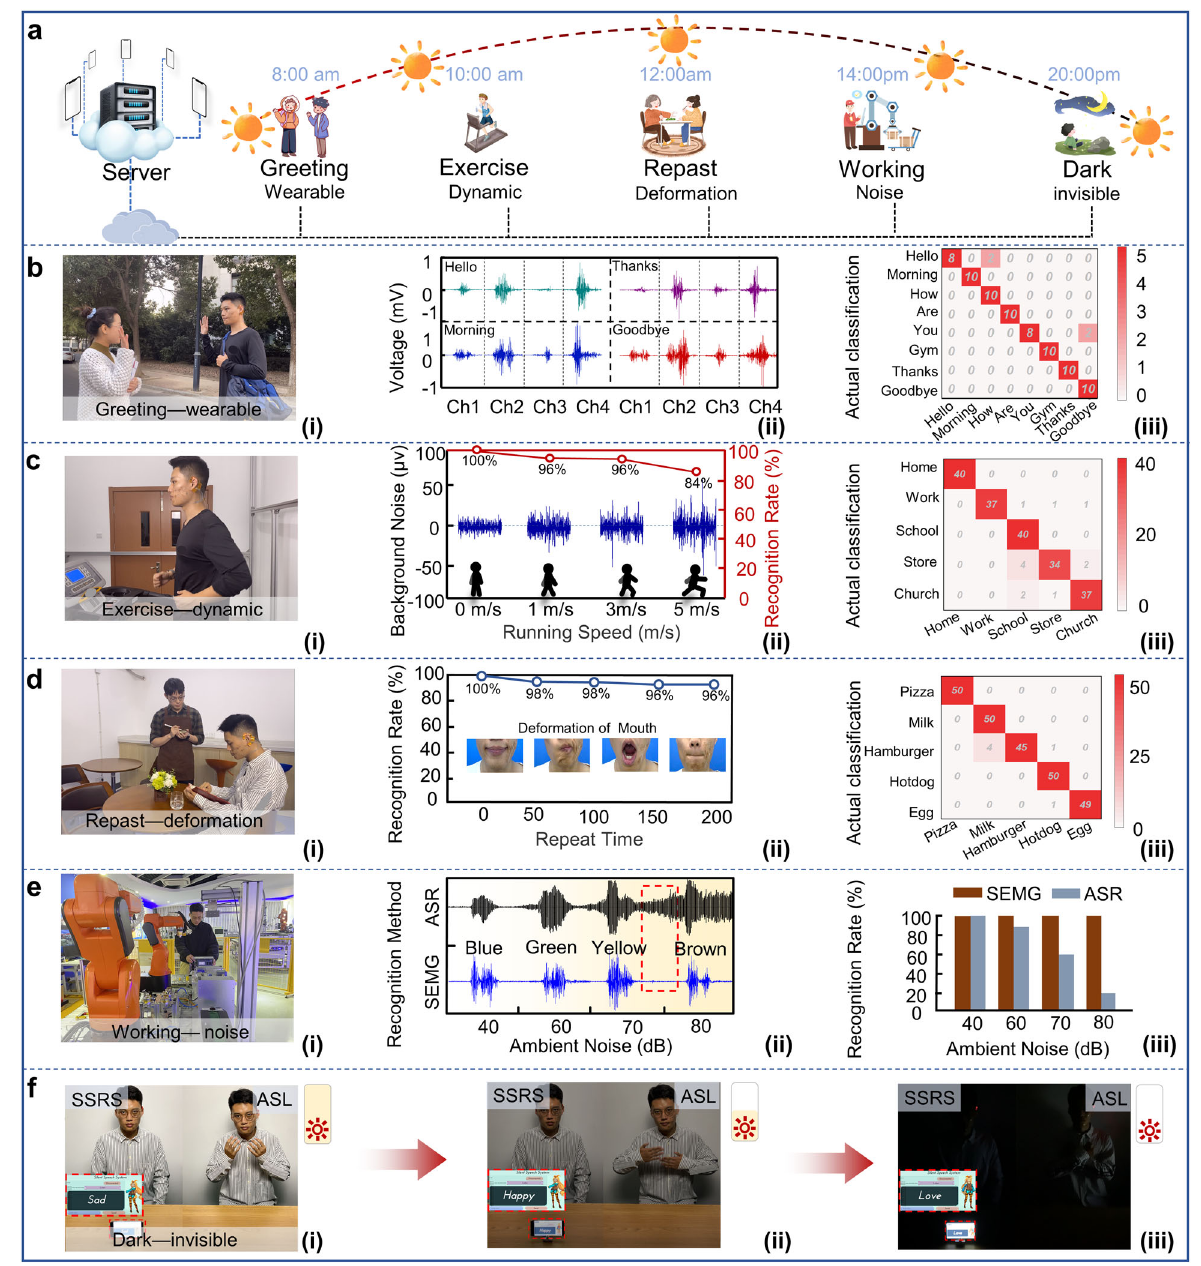
Fig. 4 All-weather demonstration of the SSRS. a Five typical scenarios experienced in daily life. b Wearable and natural communication: (i) The scene of greeting. (ii) Four-channel sEMG of four representative words. (iii) The recognition rates of eight words in the greeting scene. c All-weather use in dynamic condition: (i) The scene of exercise. (ii) The recognition rates and background noises of fi ve words related to locations under four different running speeds. (iii) The recognition rates of fi ve words related to locations in four different exercise states. d All-weather use in the large deformation condition: (i) The scene of the repast. (ii) The recognition rates of fi ve words related to food under different repeat times, each time contains four kinds of mouth deformation. (iii) The recognition rates of fi ve words related to food. e Adaptability in the noisy environment. (i) The scene of the noisy working environment. (ii) The signals of ASR and sEMG. (iii) The comparison of the recognition rates of two recognition methods under four different ambient noises. f Adaptability in the dark environment. i – iii The comparison of recognition effect of Silent Speech Recognition (left) and American Sign Language (right) in the darkened environment. The identi fi able photographs in b – f are fully consented by the written